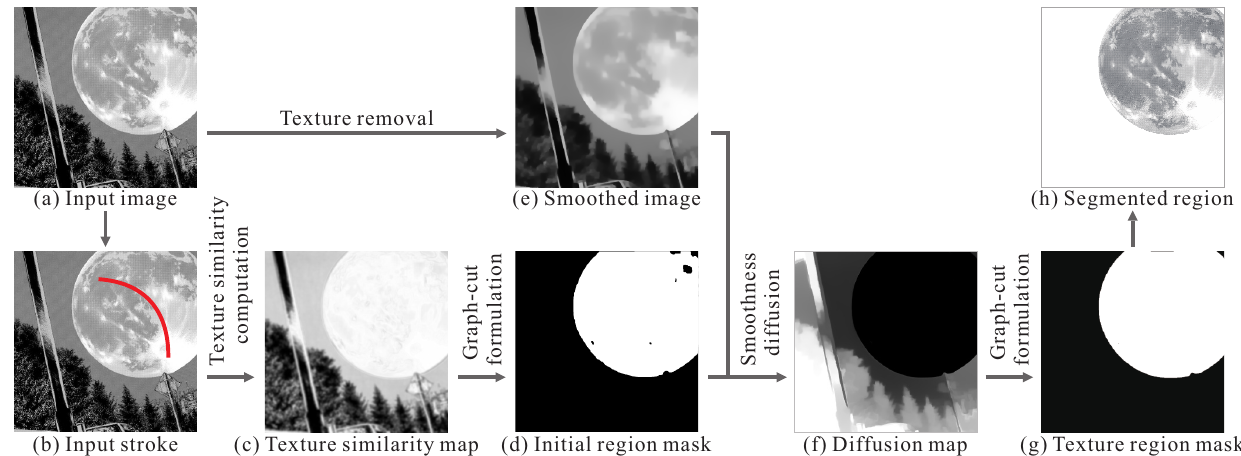
Fig. 5 System overview (image size: 778 × 764, loading time: 3.51 s, processing time: 0.58